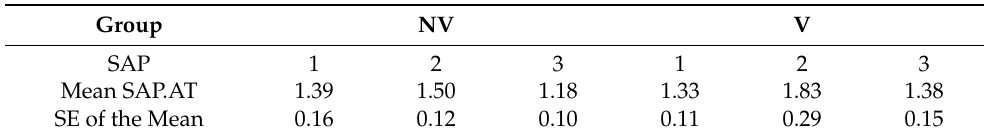
Table 6. Situation awareness probe (SAP) acknowledgment time (in seconds), divided by group and SAP number.